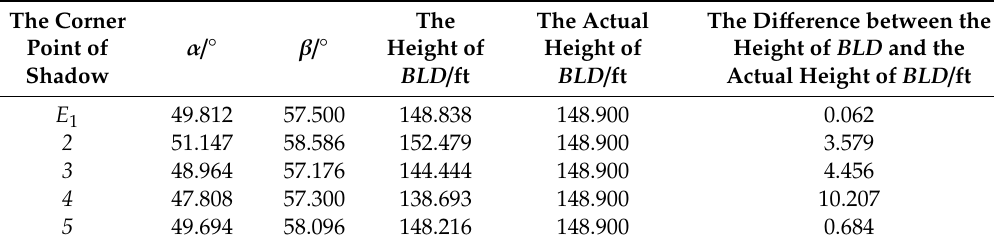
Table 1. The accuracy analysis of the solar zenith angle and the solar altitude angle.